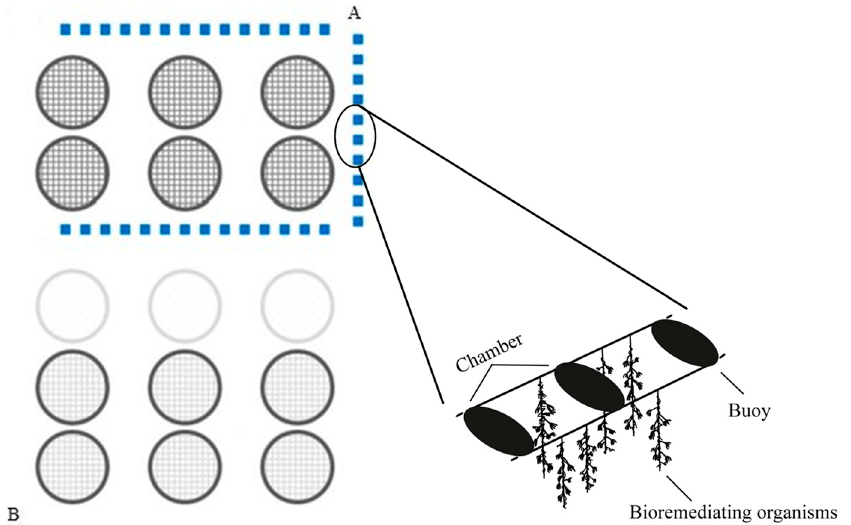
Figure 4. Sampling sites: A (Treatment site) on the upper right, B (Control site) on the lower left, selected for the analysis of the effect of the IMTA system on the benthos. Blue squares: arrangement of the breeding chambers within the long lines.